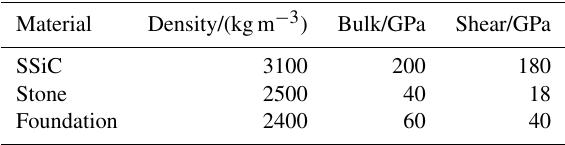
Figure 16. Maximum principle stress [Pa].